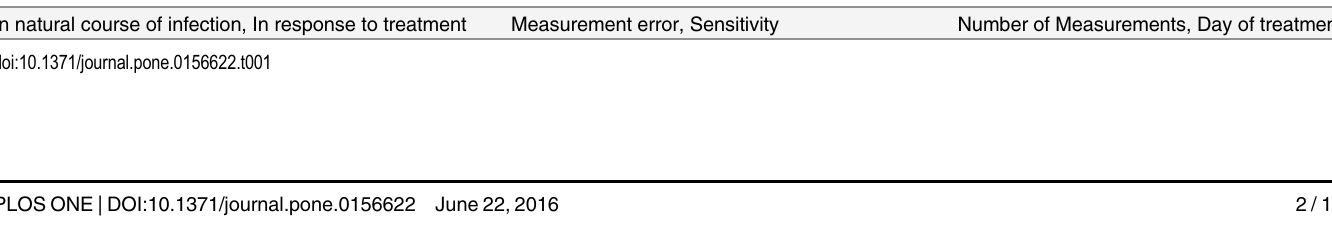
Table 1. Sources of variances in clinical trials of potential novel therapies for influenza A. Applicable to all acute viral infections. Individual variability among